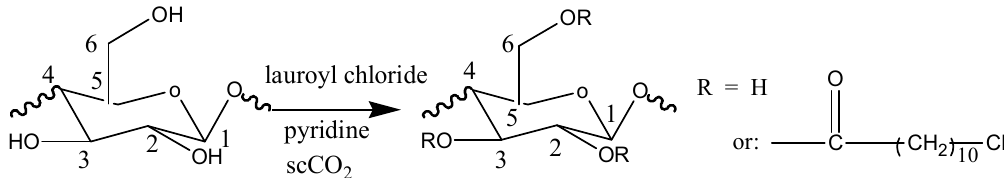
Figure 2. Synthesis of continuous screw-extrusion steam explosion (CSESE) pretreated jute fiber (JSE) laurate in scCO 2 .